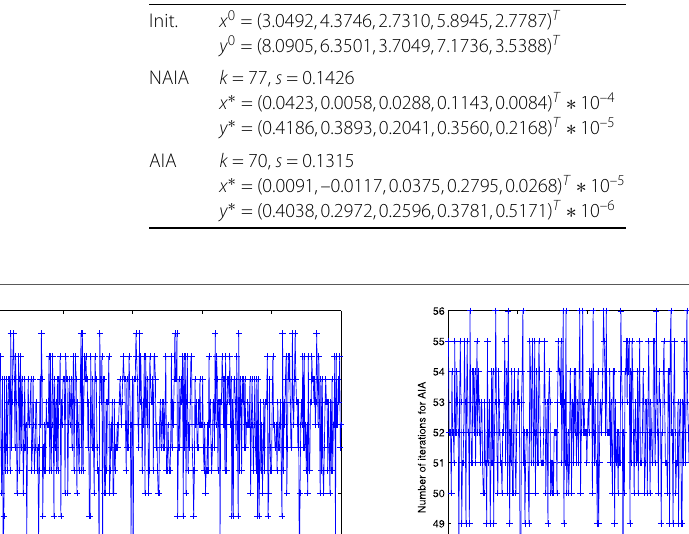
Table 2 The numerical results of Example 4.1